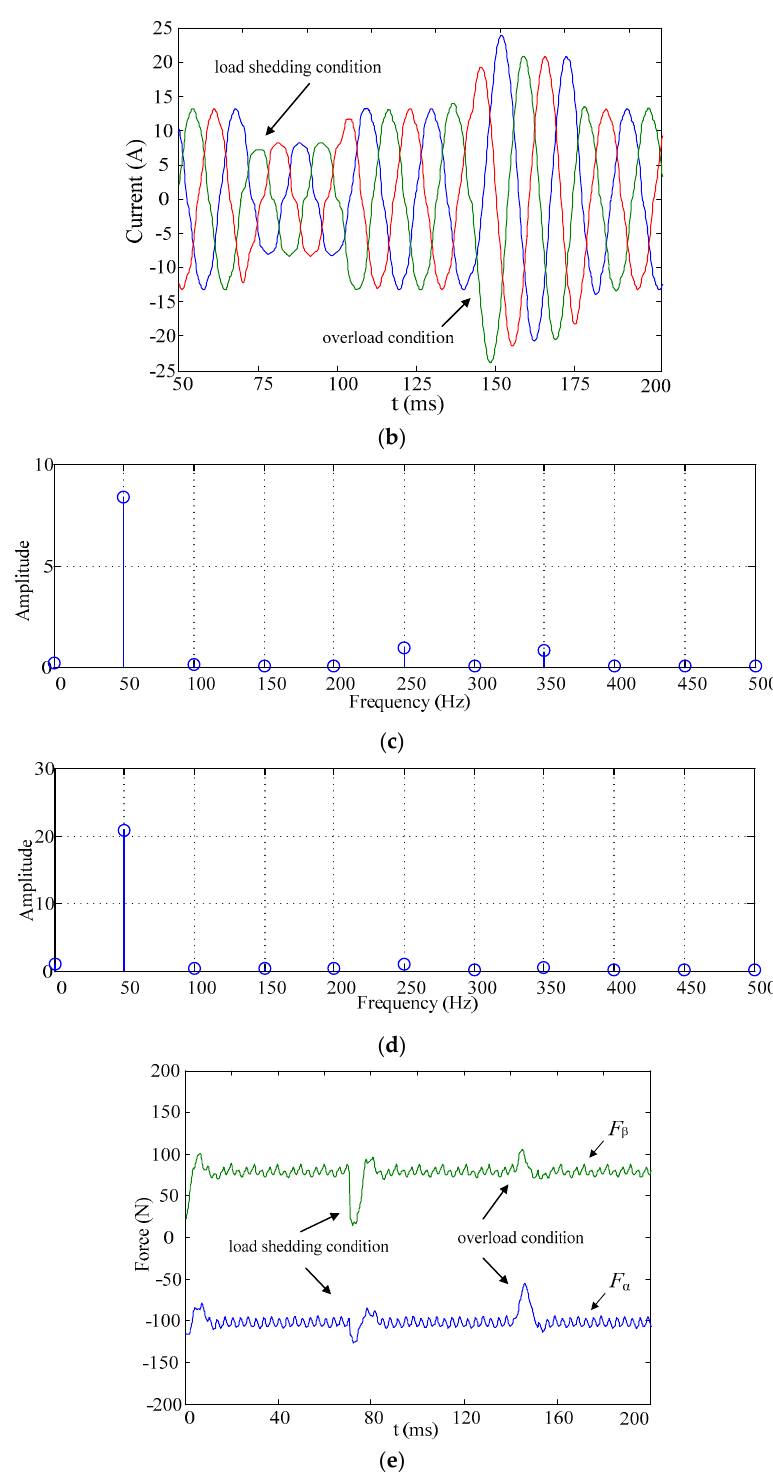
Figure 12. The performance of the generator and harmonic analysis during load disturbance. ( a ) The output voltage effective value; ( b ) The generation winding induced current; ( c ) Winding current harmonic under load shedding condition; ( d ) Winding current harmonic under overload condition; ( e ) The suspension force in the process of operation.